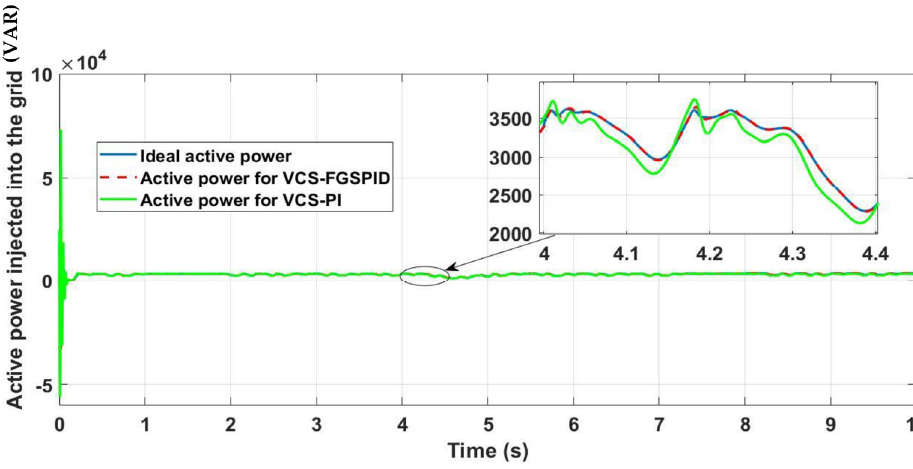
Figure 41. Hardware co-simulation for active grid-injected power.